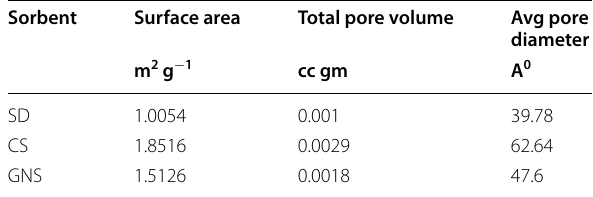
Table 2 BET analysis results for SD, CS and